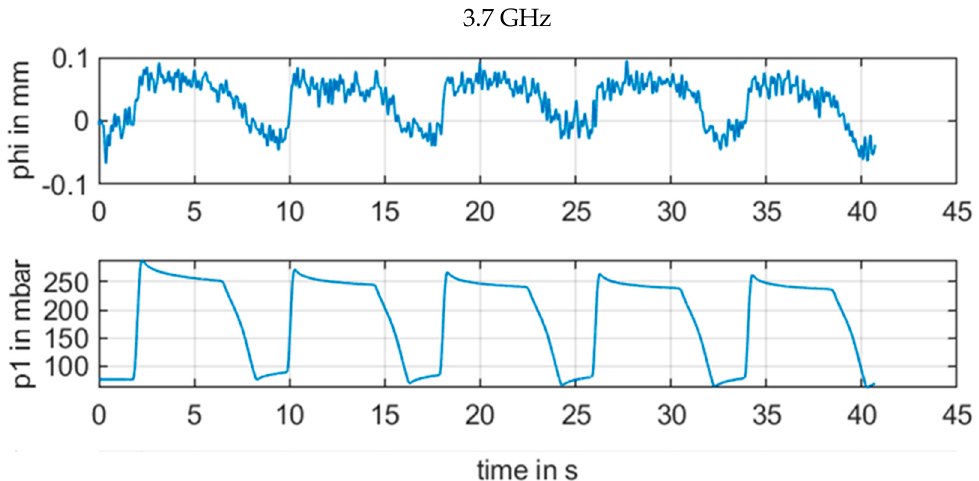
Figure 11. Measurement results for 𝜙 (cid:3040) (cid:4670)mm(cid:4671) of CW radar with frequency of 3.3 GHz in comparison with reference pres- sure p1 from pressure sensor.